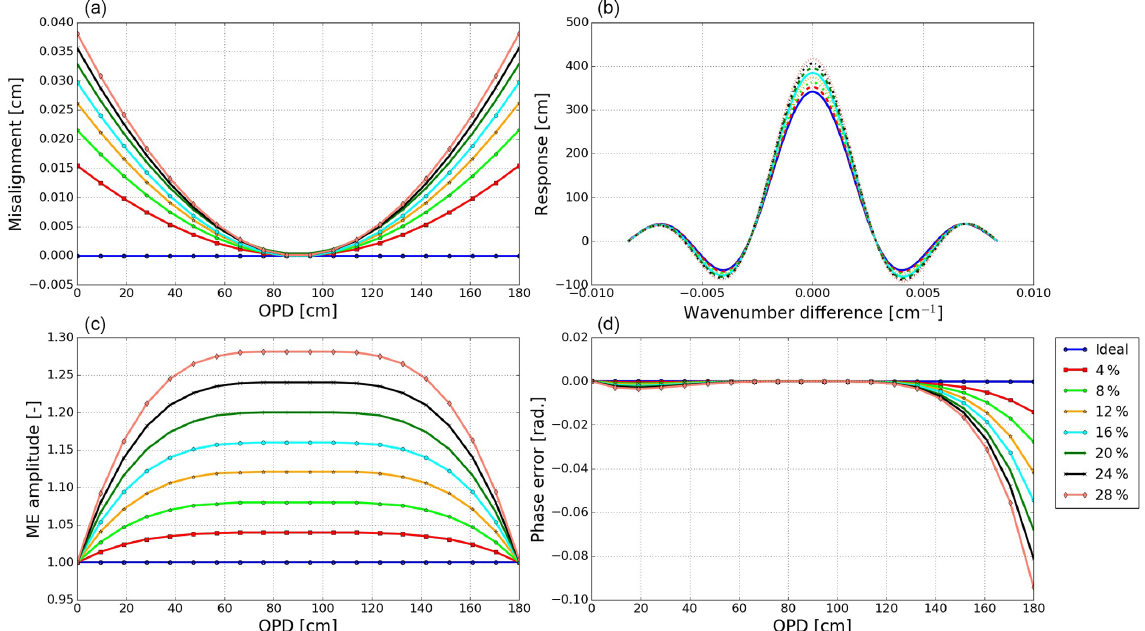
Figure 10. Simulated positive ME deviations along with the OPD. Panel (a) demonstrates the misalignment, panel (b) shows the resulting ILS, panel (c) shows the resulting ME amplitude, and panel (d) shows the resulting PE.